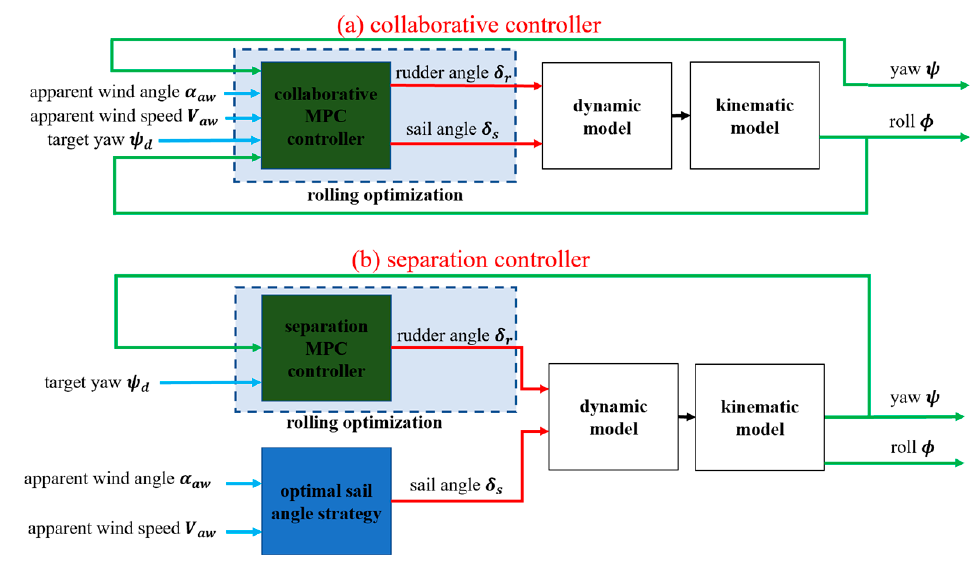
Figure 3. ( a ) Flow chart of collaborative control; ( b ) Flow chart of separation control.